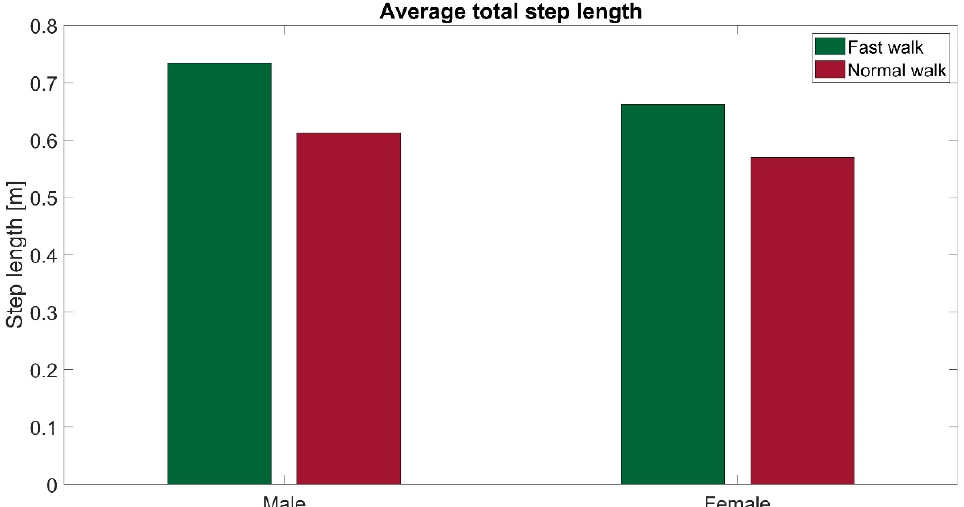
Figure 13. Comparisons of step length during fast walking speed and normal walking speed be- tween male participants and female participants.